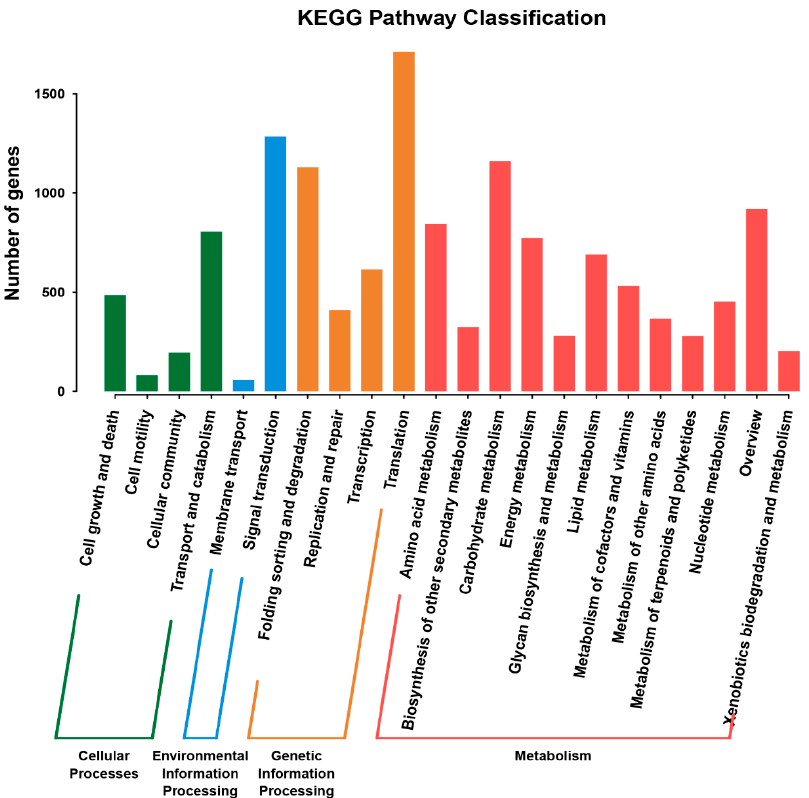
Figure 3. Plots showing categories of genes classified based on the Kyoto Encyclopedia of Genes and Genomes (KEGG) analysis. Genomes (KEGG)